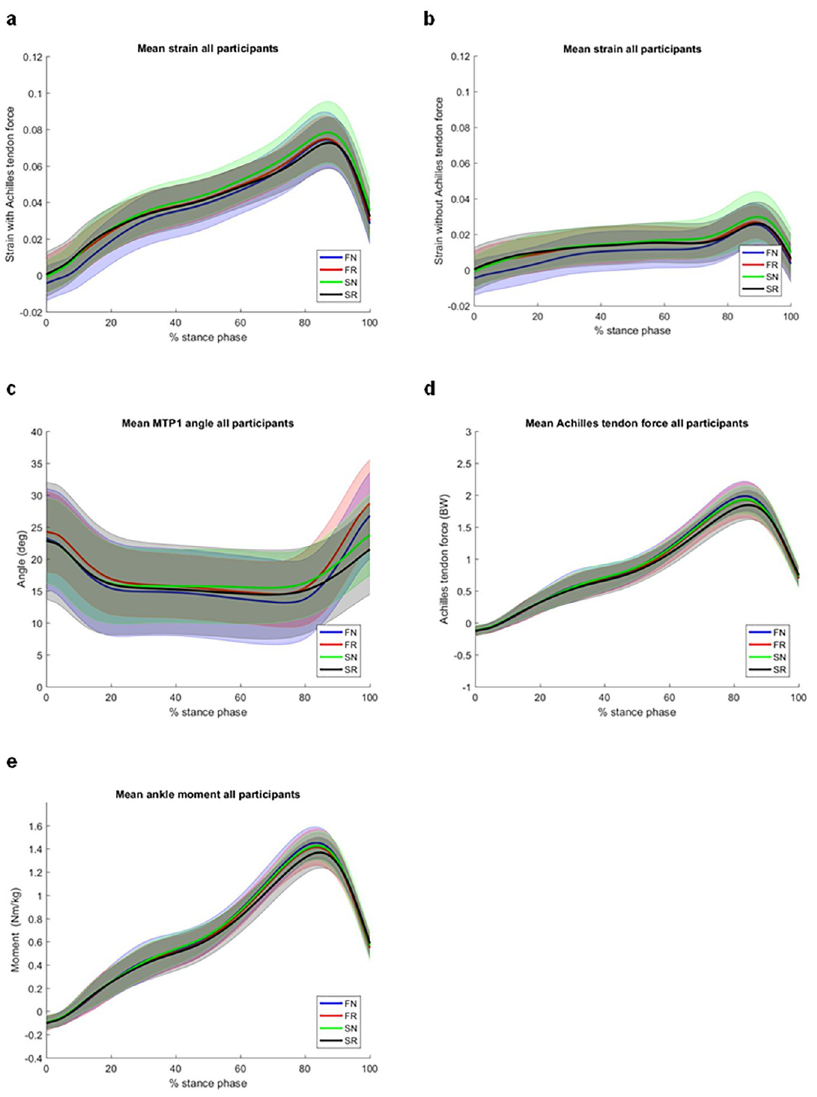
Fig 5. Effects of shoe condition on biomechanical variables during stance phase. Average values for PA strain with (a) and without (b) Achilles tendon force, MTP1 angle (c), plantarflexion moment (d) and Achilles tendon force (e) per condition during stance phase for all participants. Shading indicates between subjects standard